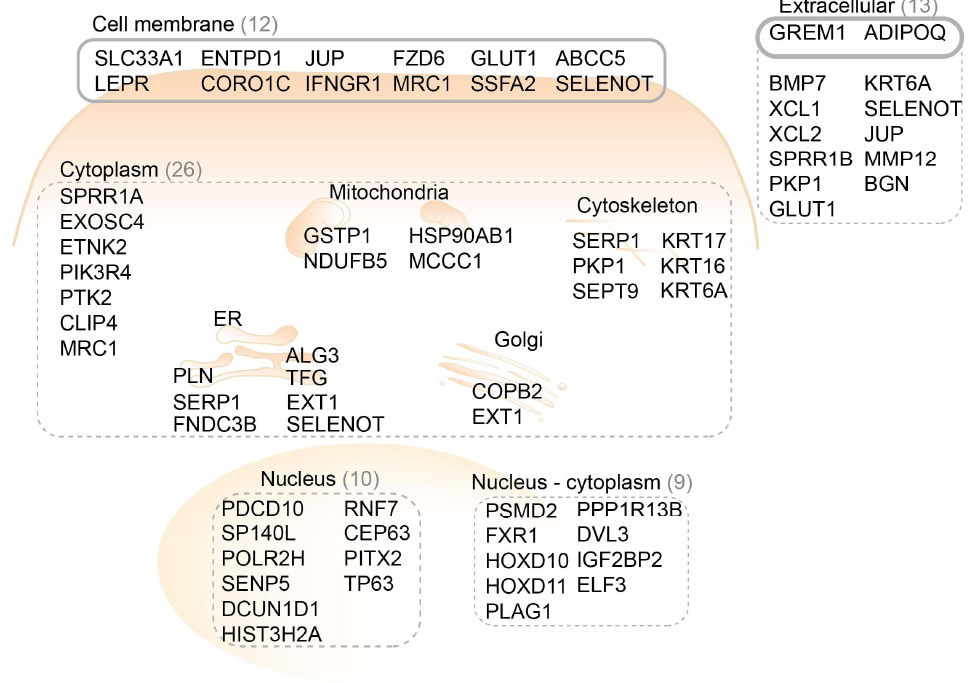
Figure 1. The sub-cellular localization of the protein products of the top 60 FGmRNA-overexpressing genes. The proteins localized on a cell membrane are more easily accessible and especially suitable as imaging targets. ER, endoplasmic